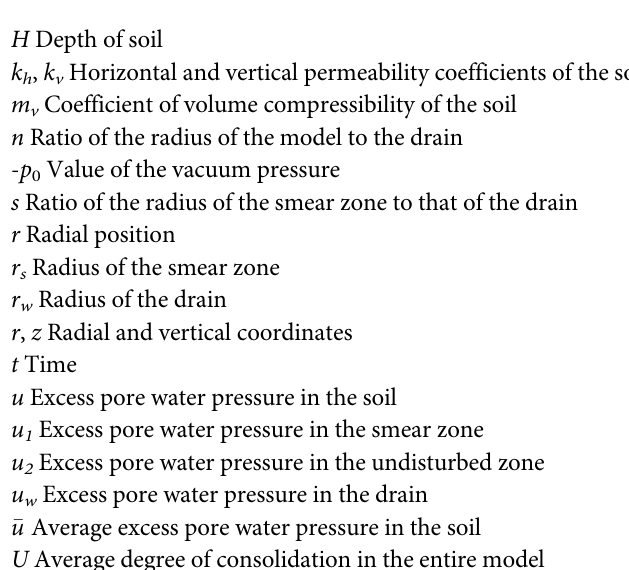
S1 Fig. Data of Fig 3.